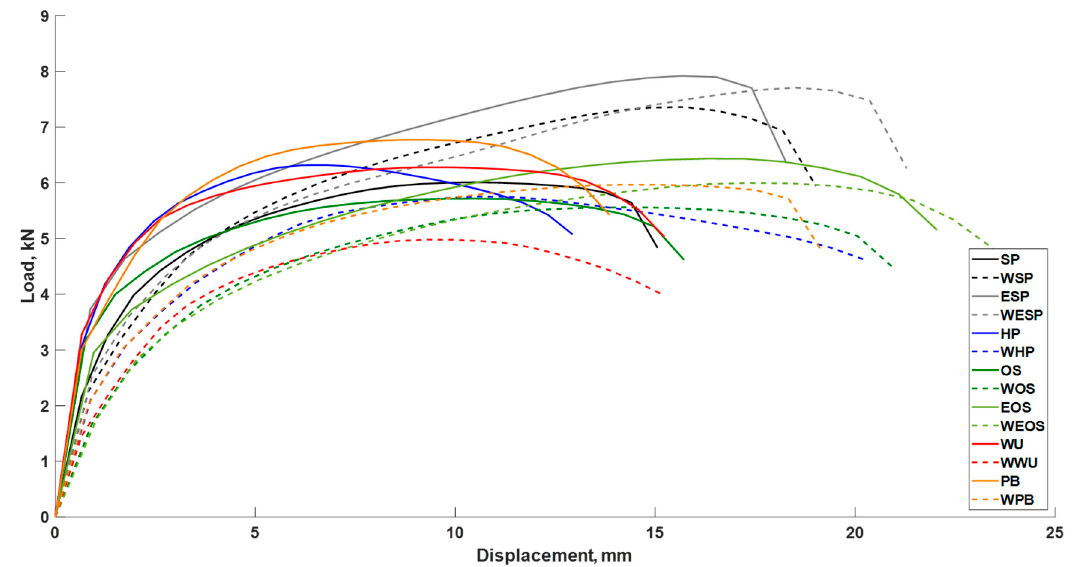
Figure 8. Averaged backbone plots by group tested under cyclic loading protocol.